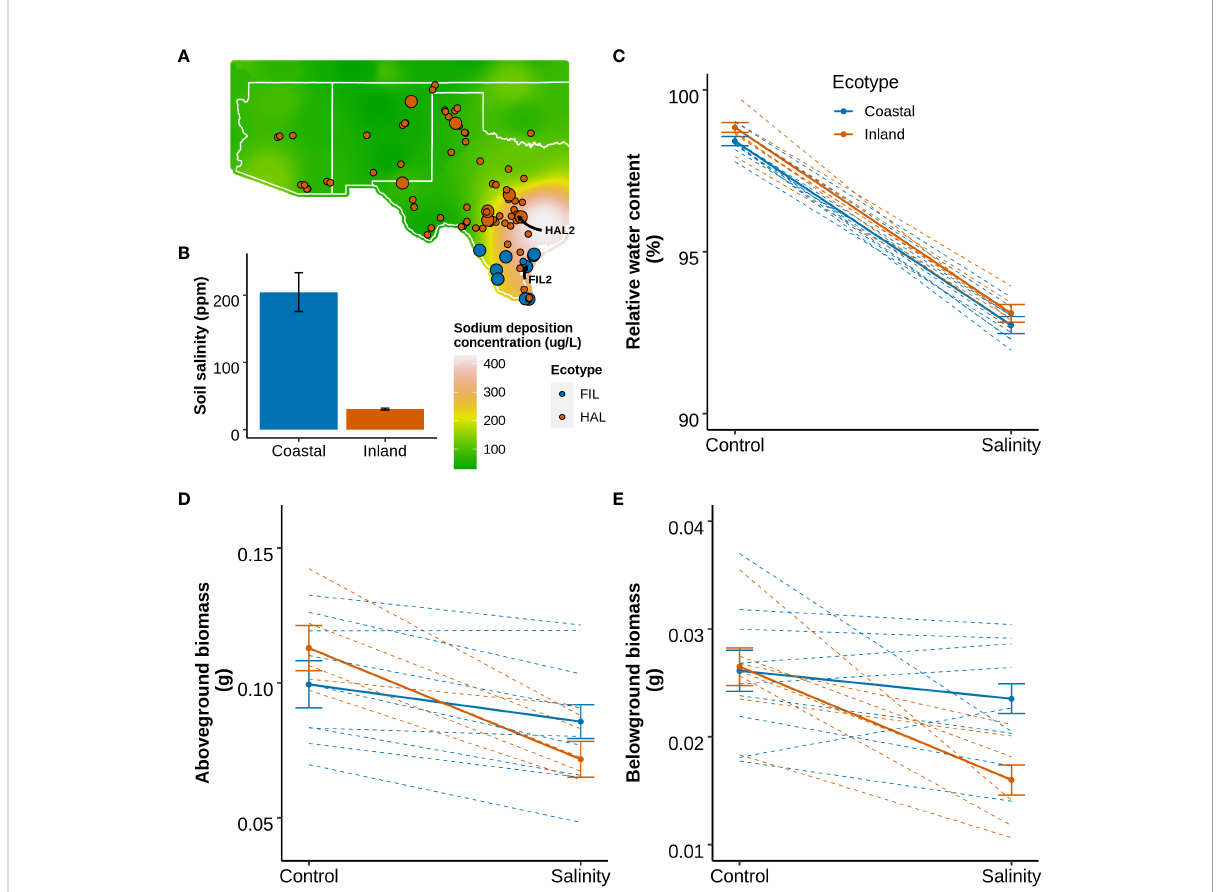
FIGURE 1 Geographical distribution of P. hallii from natural collections and the phenotypic response to salinity of selected inland and coastal accessions. (A) Geographical distribution of P. hallii in which fi lled points represent the collection location of accessions while color represents ecotypic variation. Raster plot represents annual soil sodium deposition collected from National Atmospheric deposition program for the year 2018 (https://gaftp.epa.gov/castnet/tdep/2021_01_grids/). Points with larger radius represent the selected inland and coastal accessions that have been tested in our salinity response experiment. (B) Bar plot of sodium concentration measured from the top soil of several coastal and inland habitats. (C – E) Reaction norm plots at two different treatment levels (Control and Salinity stress) for leaf relative water content, aboveground biomass, and belowground biomass respectively. The solid and dotted line represents ecotype speci fi c and genotype speci fi c group means